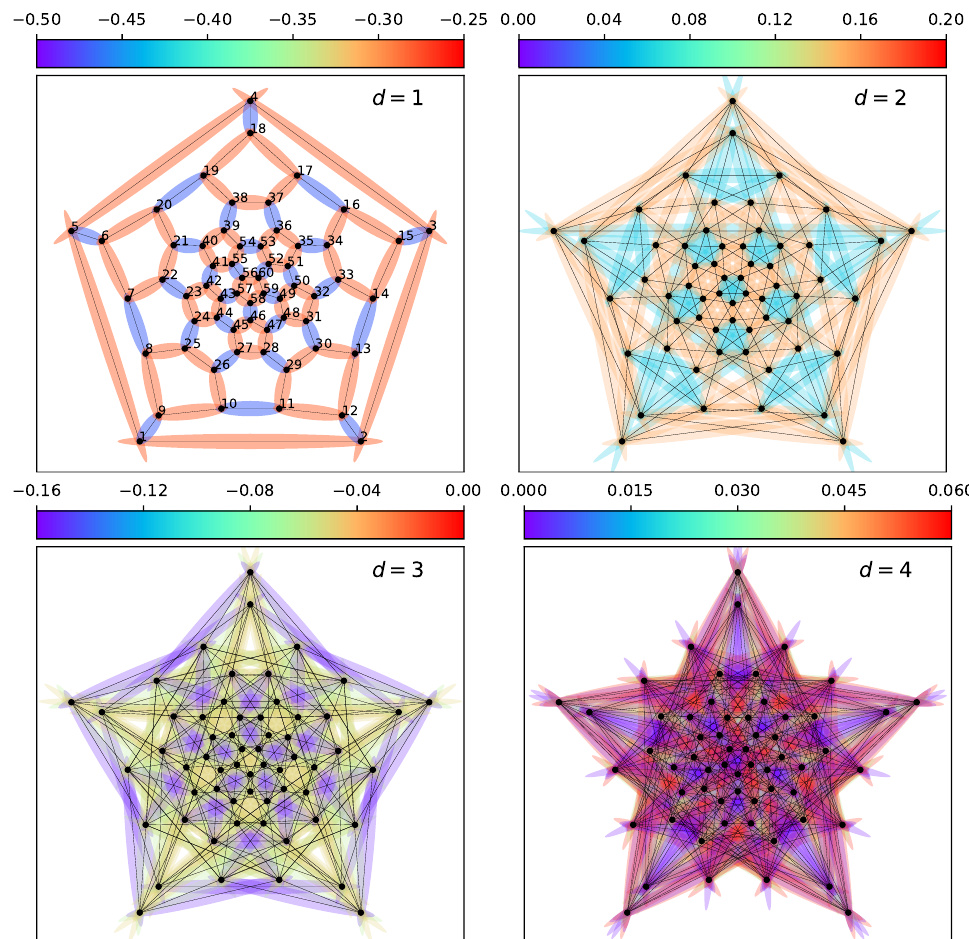
〉 in the ground d . 60